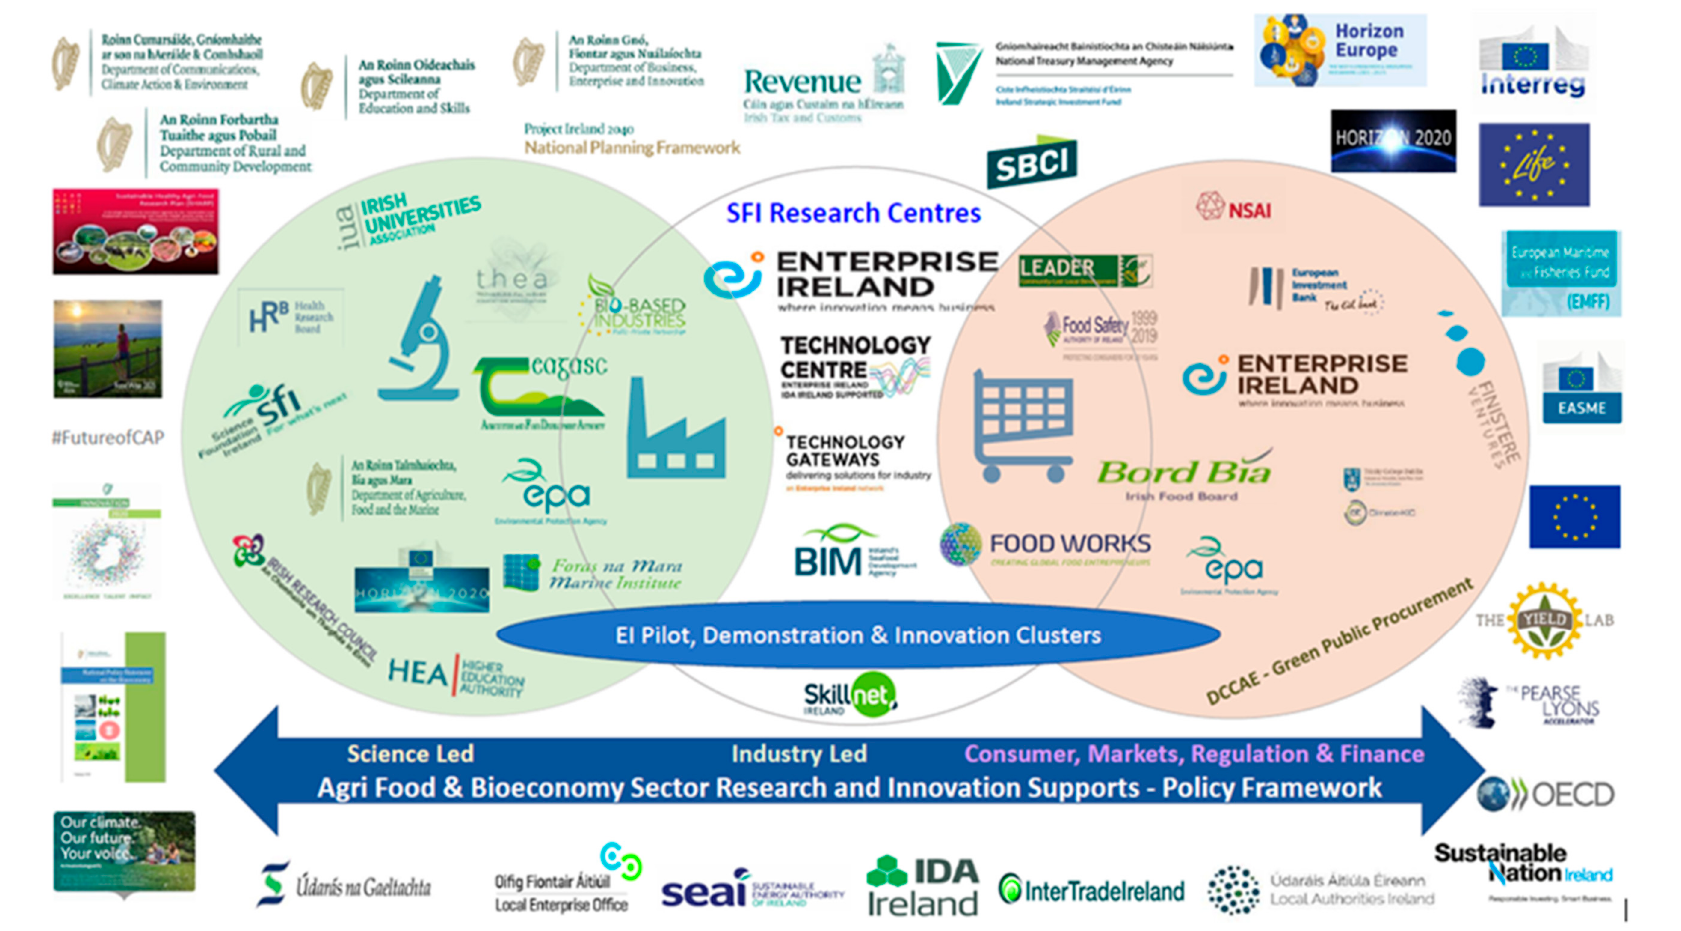
Figure A1. Map of funding sources available for the Irish